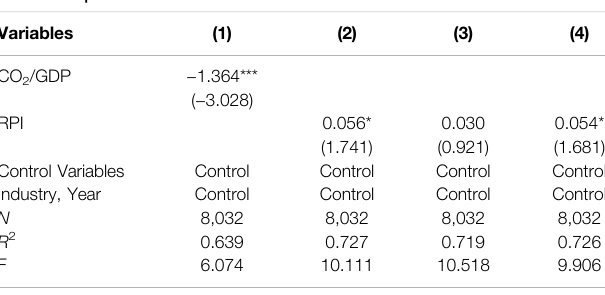
TABLE 14 | The results of robustness